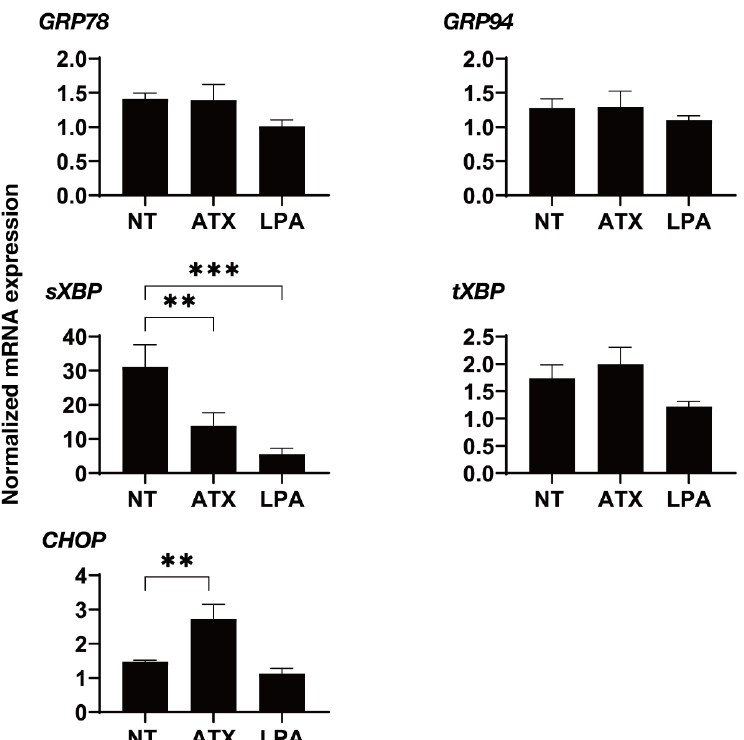
Figure 7. mRNA expression of ER-stress related genes in 3D cultured HTM cells. During the 6-day culture of the 3D HTM spheroids, they were exposed to 2 mg/L ATX or 200 nM LPA during Day 5 through 6, and the mRNA expression of ER-stress related genes including major ER stress related genes of inositol-requiring enzyme 1 (IRE1), glucose regulator protein (GRP)78, GRP94, the X-box binding protein-1 (XBP1), spliced XBP1 (sXBP1) and CCAAT/enhancer-binding protein homologous protein (CHOP) were measured. All experiments were performed in duplicate using fresh preparations. Data are presented as the arithmetic mean ± standard error of the mean (SEM). ** p < 0.01, *** p < 0.005 (ANOVA followed by Tukey’s multiple comparison